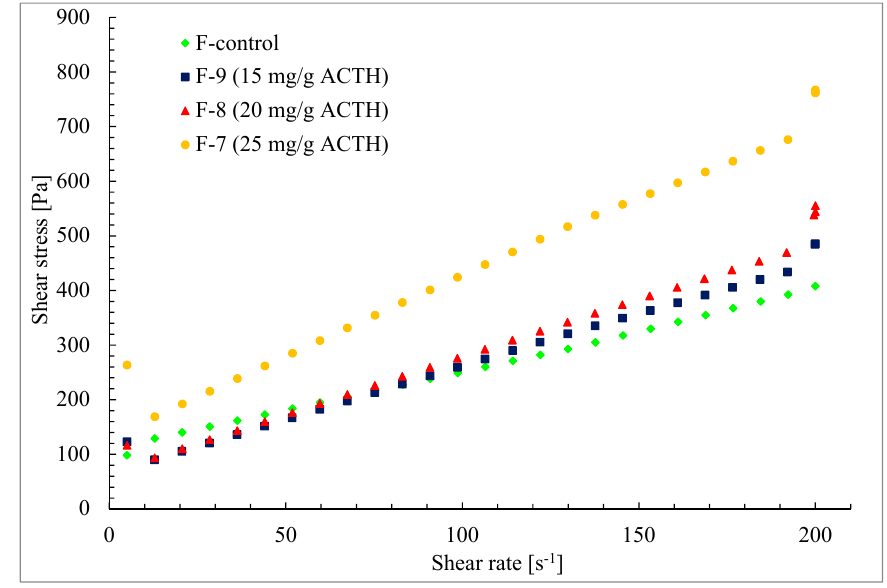
Figure 5. The flow-curves plotted for the ointments F-7–F-9 and F-control in the controlled stress mode.